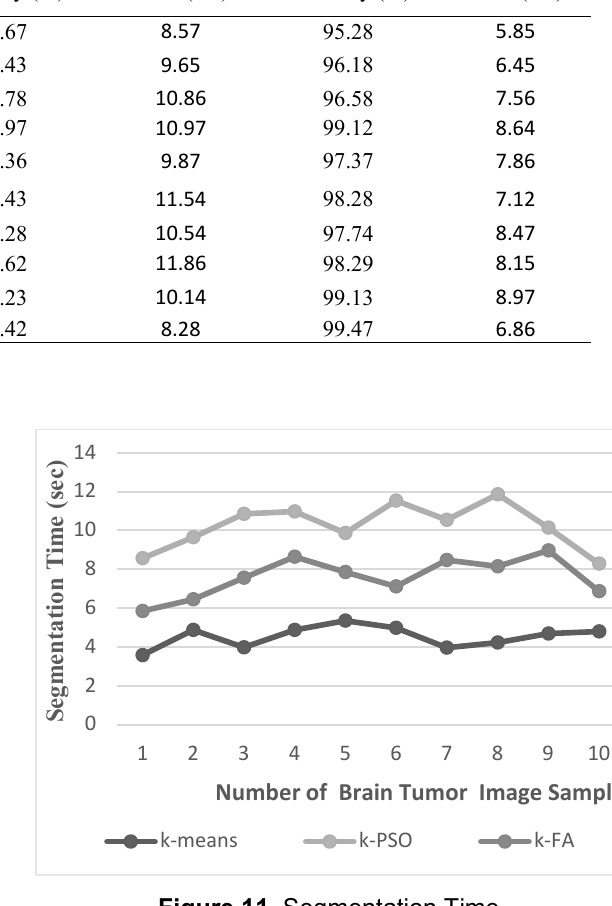
Table 5. Accuracy and Segmentation time comparison obtained using k-means, k-means with PSO and k-means No. of Image